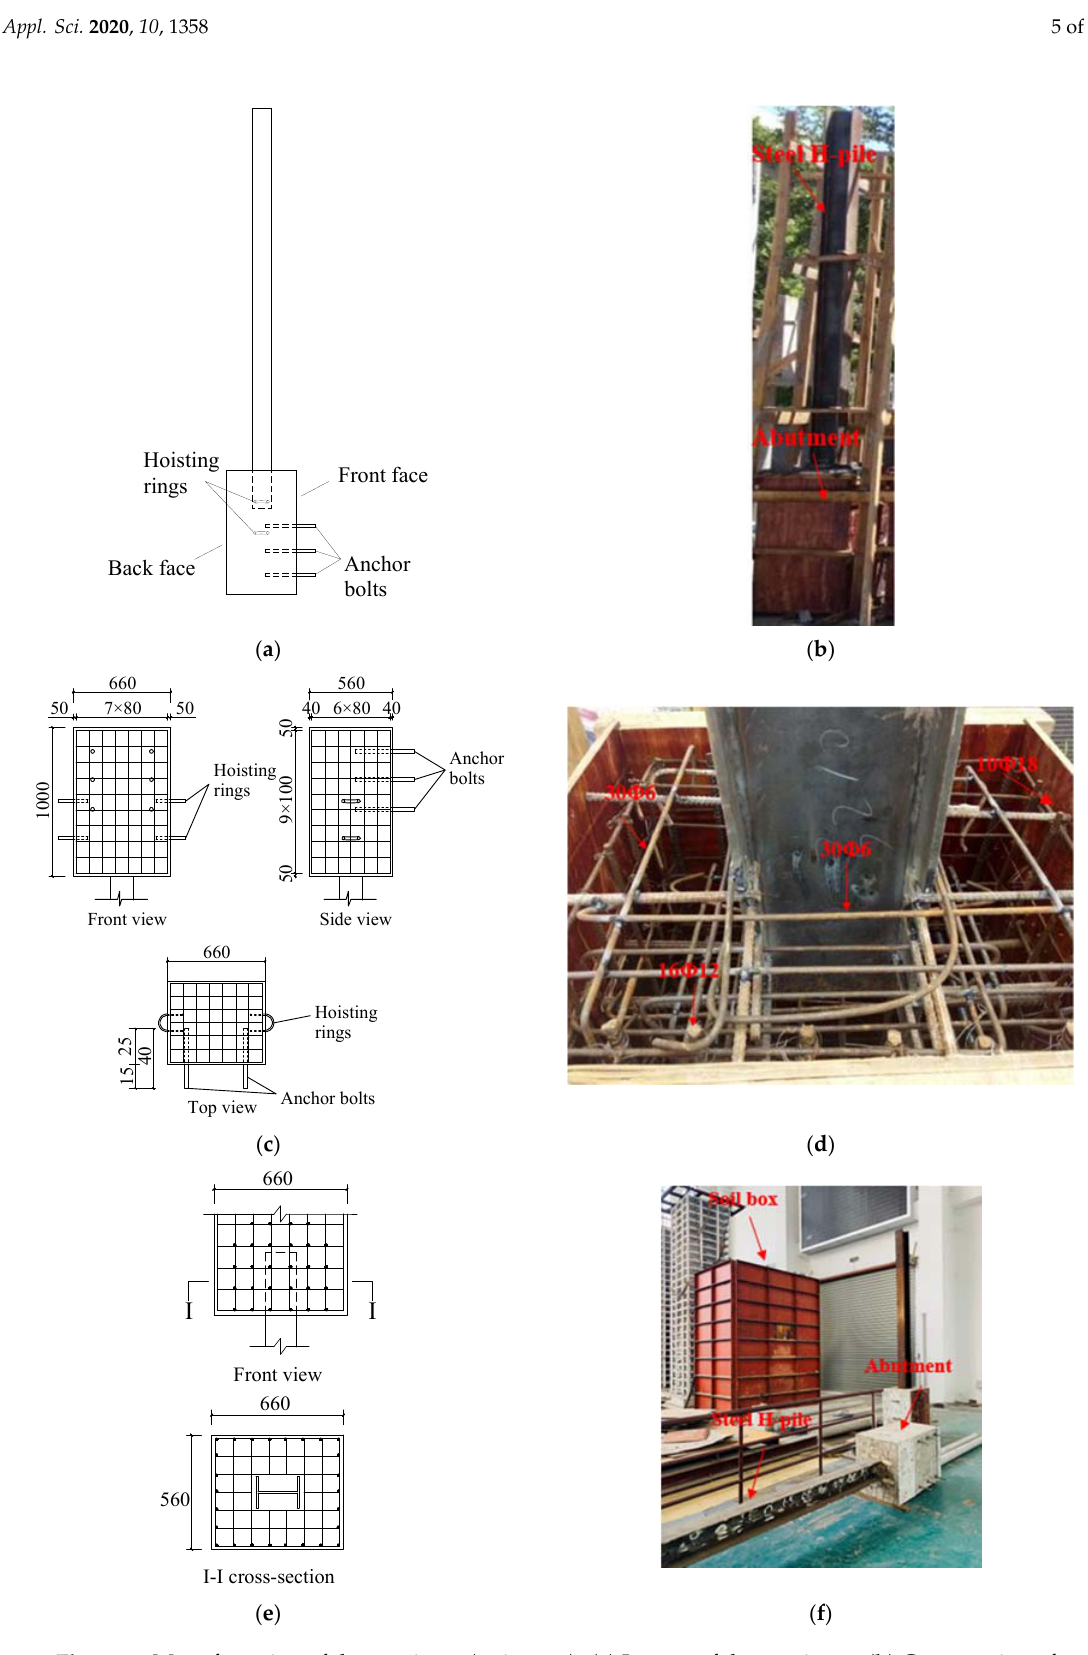
Figure 2. Manufacturing of the specimen (unit: mm). ( a ) Layout of the specimen. ( b ) Construction of the specimen. ( c ) Reinforcement layout of abutment. ( d ) Photo of steel layout of pile and abutment. ( e ) Details of consolidation of pile and abutment. ( f ) Photo of Abutment ‐ pile specimens and soil box.